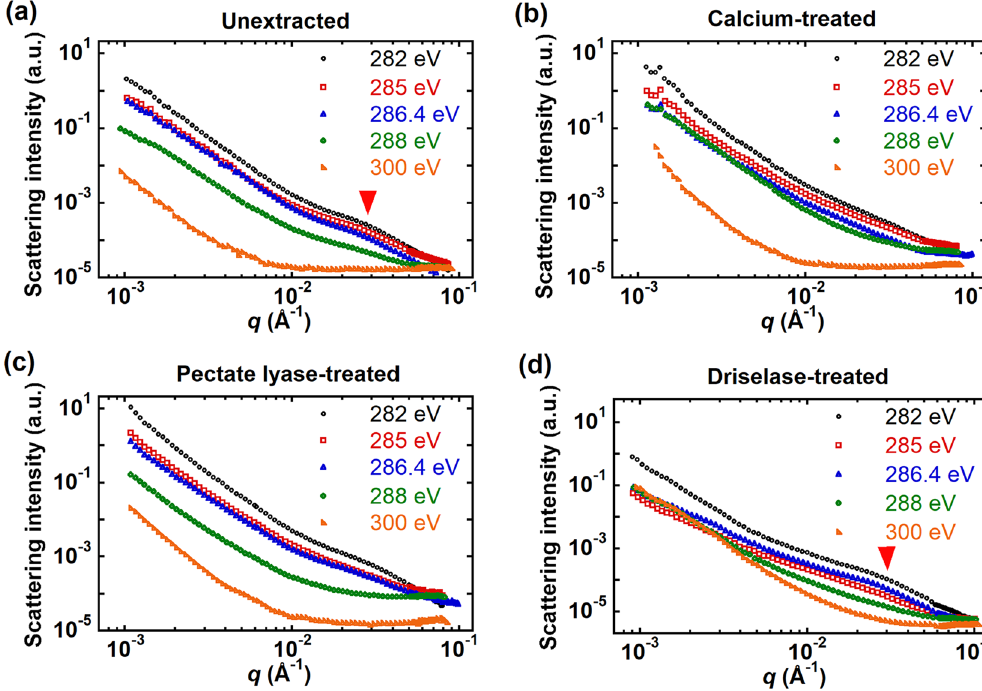
Figure 7. RSoXS profiles of ( a ) unextracted, ( b ) calcium-treated, ( c ) pectate lyase-treated, and ( d ) Driselase- treated onion 11 th scale epidermis near the carbon K-edge. Scattering profiles are shifted vertically for clarity. Data acquired in the transmission geometry (X-rays normal to the epidermis).